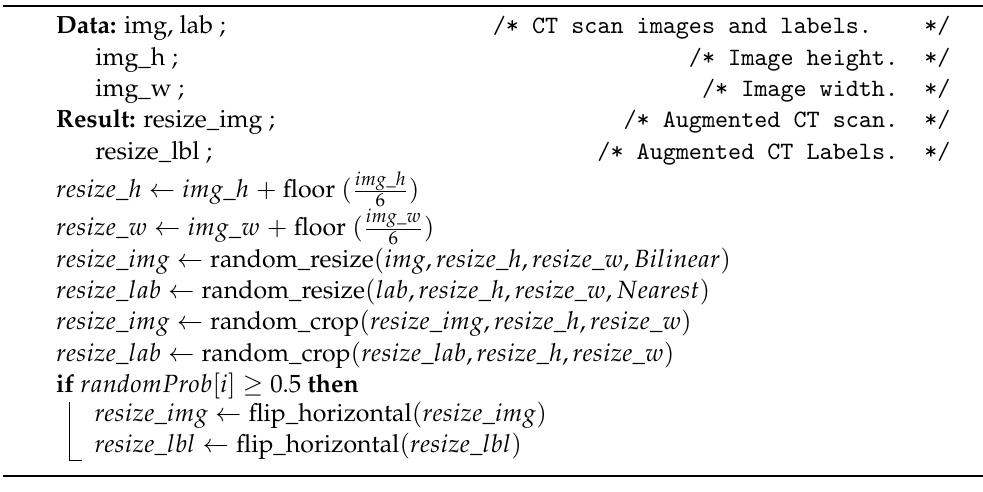
Algorithm A1: IVCF image augmentation algorithm for the deep learning model